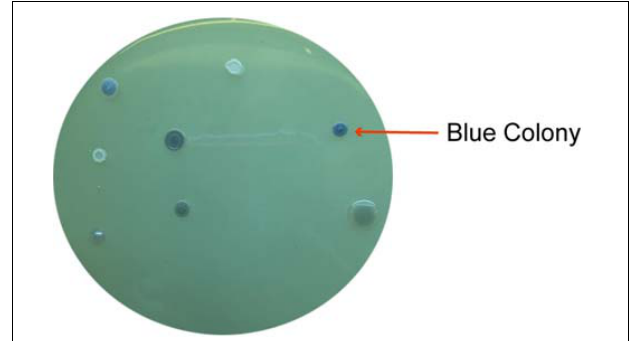
FIGURE 1 | Several blue colonies on LPMA indicated the molybdenum-reducing ability of the isolated